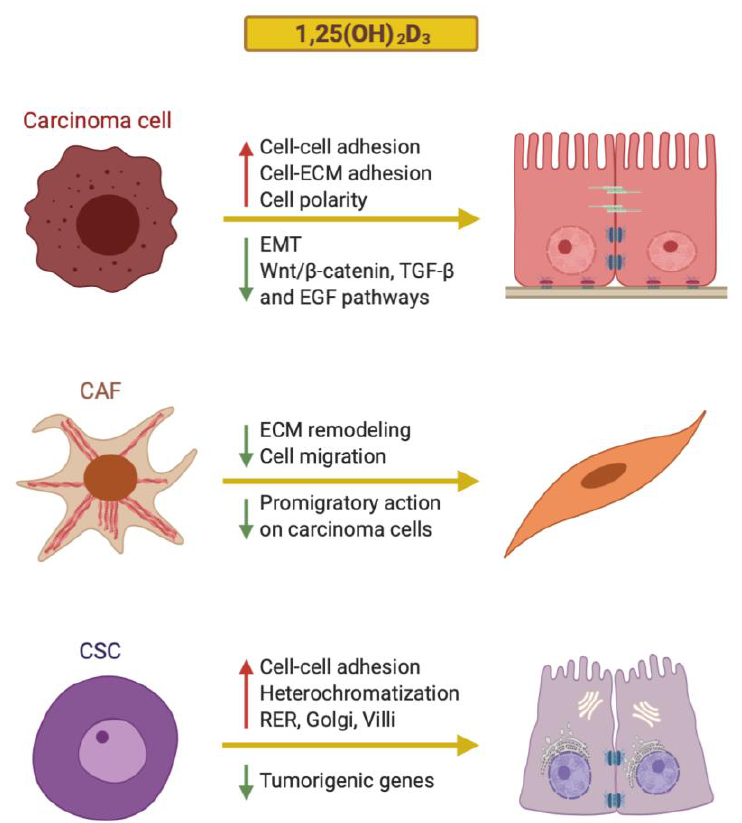
Figure 2. Schematic representation of the mechanisms by which 1,25(OH) 2 D 3 regulates the differentiation of human colon carcinoma cells, cancer-associated fibroblasts (CAFs) and cancer stem cells (CSCs).